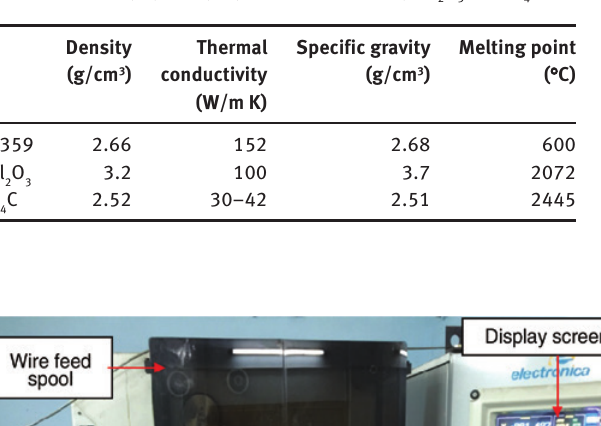
Table 1: Thermophysical properties of A359 alloy, Al